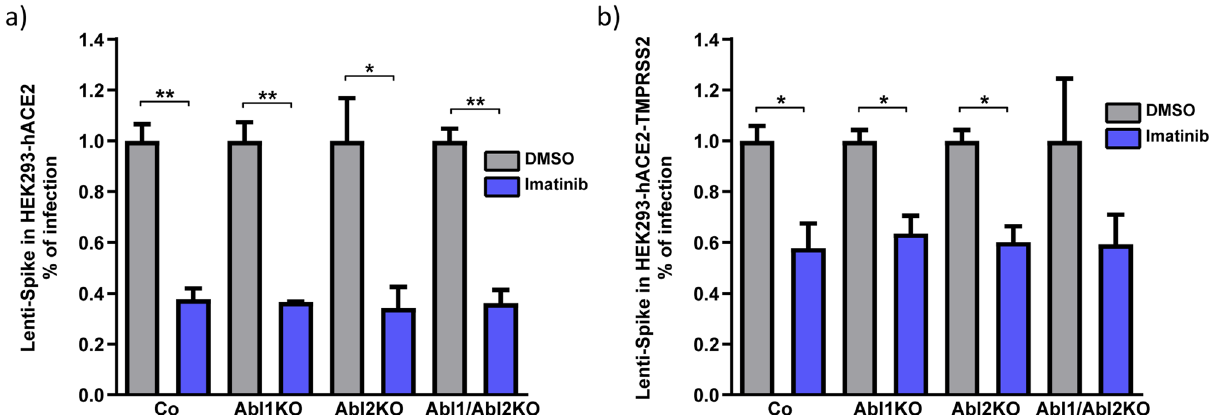
Figure 4. Lenti-Spike inhibiting effects of imatinib were Abelson-kinases independent. ( a ) Lenti-Spike inhibition by imatinib is Abelson-kinases independent in TMPRSS2-negative cells. HEK293-KO cells for each Abl1, Abl2 or both, were transfected with hACE2 2 days before infection. Lenti-Spike infection is reduced in the same level in all the tested cell lines when treated with 10 µM imatinib at the time of infection. Results represent means of two independent experiments with two biological replicates each. ( b ) Abelson-kinases are not responsible for lenti-Spike inhibition with imatinib in TMPRSS2-positive cells. The Abl-KO cell lines were transfected with TMPRSS2 and hACE2 2 days before lenti-Spike infection. Results represent means of two independent experiments with two biological replicates each and student-t-test was applied; * p ≤ 0.05; ** p ≤